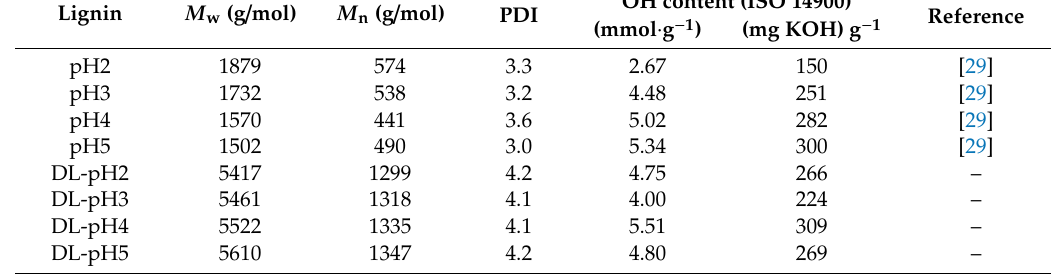
Table 2. Weight-average ( M w ) and number-average ( M n ) molecular weight and polydispersity (PDI) obtained by gel permeation chromatography (GPC) measurements, and OH content according to ISO 14900 for demethylated lignins (DL) and Kraft lignins isolated at different pH values [29].